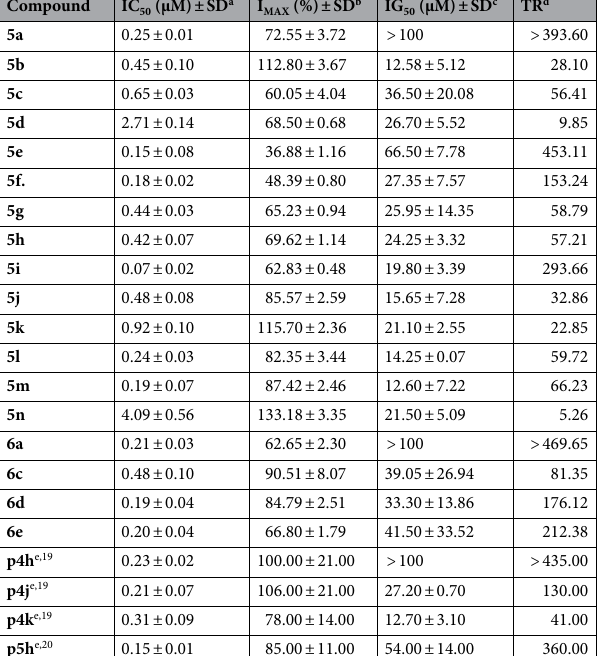
Table 1. Inhibition of ABCG2-mediated efflux and cytotoxicity. The inhibition of ABCG2-mediated mitoxantrone efflux was assayed in HEK293- ABCG2 cells. a The affinity of inhibitor interaction was expressed as IC 50 values (compound concentrations giving a half-maximal inhibition). b The maximal inhibition percentage (I MAX ) was determined by IC 50 fitted curves. c The cytotoxicity was expressed as IG 50 values (compound concentrations giving a half-maximal cell viability). d The therapeutic ratio (TR) corresponds to the ratio between IG 50 and IC 50 values. e Experimental data of compounds p4h , p4j , p4k and p5h correspond to those previously